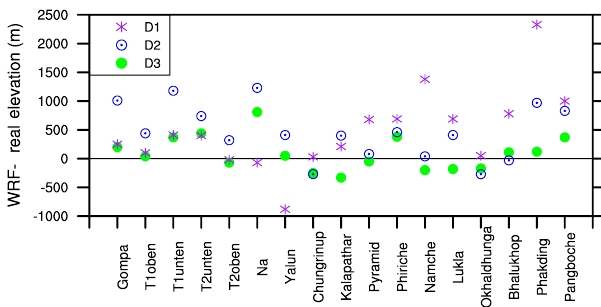
Figure 2. Difference between WRF-simulated and real elevation for three WRF resolutions at air temperature station